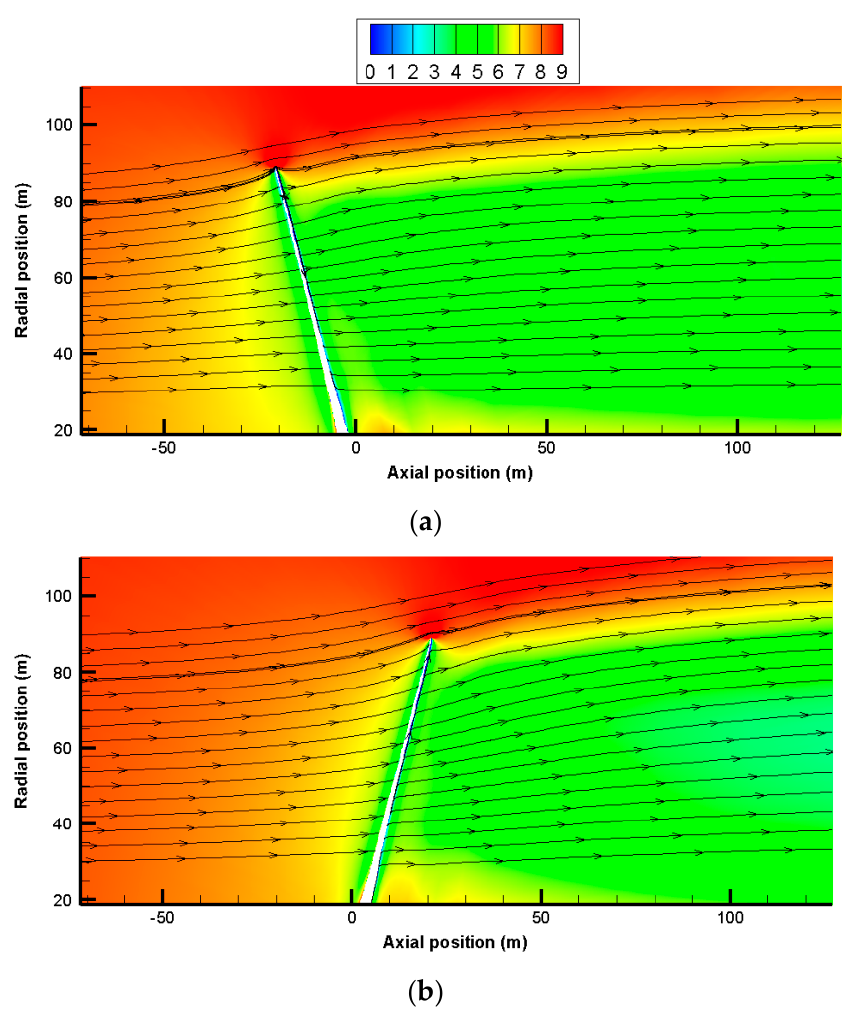
Figure 8. Streamlines in the YZ plane with axial velocity contours for the two coned configurations: ( a ) upwind coned rotor of T trans = 5/ R , C cone = − 4; ( b ) downwind coned rotor of T trans = 5/ R , C cone =